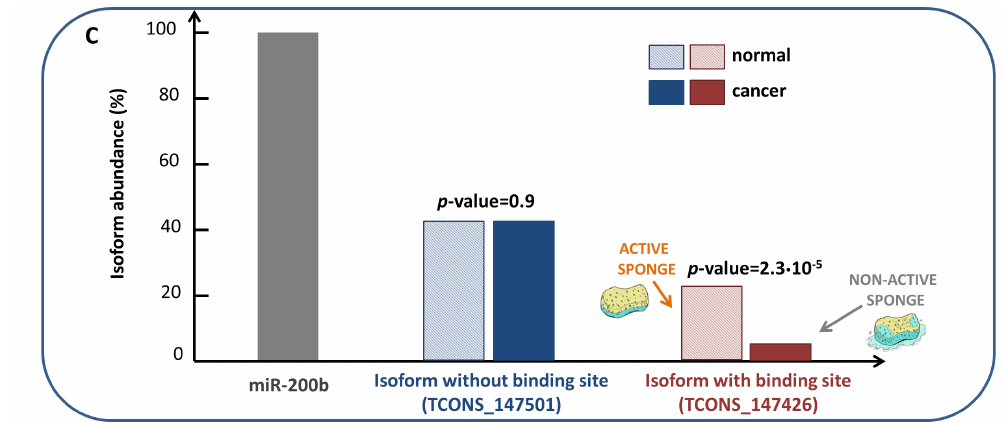
Figure 4. Analysis of PVT1 isoforms [27]. ( A ) Sketch of PVT1 genomic locus as reconstructed by Cufflinks spans across a genome interval of over 300 kb (i.e., 128,806,789-129,113,603 bases within the February 2009 human genome build GRCh37/hg19) on the forward strand of chromosome 8. PVT1 locus gives rise to 91 different variants according to raw RNA-seq data of TCGA (The Cancer Genome Atlas) for breast invasive carcinoma. The isoform names correspond to an increasing symbolic numbering and not to the actual nomenclature of the PVT1 variants. Lines represent introns and boxes (violet and grey) represent exons. Violet boxes correspond to the binding sites for the miR-200 family members. Note that some isoforms lack such binding sites (e.g., Iso11 and Iso12). ( B ) (Left) The percent variability explained by each principal component (PC) shown by the Pareto chart. This chart contains both bars and a line graph, where individual values are represented in descending order by bars, and the line represents the cumulative total value. The y-axis represents the percentage of the data variance explained by each PC, whereas the x-axis represents the principal components that are able to explain the first 100% of the cumulative distribution. PCA is performed using the variations of all the isoforms between normal and cancer tissues. (Right) The scatter plot of the projection of the original data (i.e., the variations of all the isoforms between normal and cancer tissues) onto the first two PCs; the x-axis contains the first PC while the y-axis contains the second PC. In this plot, it is possible to group isoforms in three classes: the isoform missing the binding site for the miR-200 family members (blue isoform, TCONS_147501), the isoform with the seed match for the miR-200b/200c/429 cluster (red isoform, TCONS_147426), and all the others. The first PC is able to separate the variation of the blue isoform from the others; the second PC is able to separate the variation of the red isoform from the others. ( C ) The ratio between the abundance of the red isoform (TCONS_147426, with the binding site for the miR-200b/200c/429 cluster) and blue isoform (TCONS_147501, without the binding site) with respect to the miR-200b in both normal (striped rectangle) and cancer tissues (full boxes). In the normal tissues only the isoform of PVT1 gene harboring the binding site for the miR-200b/200c/429 cluster acts as a sponge regulator of the miR-200 family members. In cancer tissues, it stops working as a sponge since its concentration is much lower than the concentration of the miR-200 family